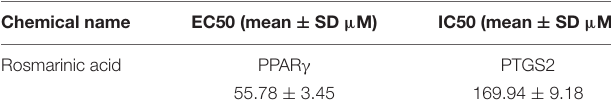
TABLE 3 | The relative affinity of RosA for PPAR γ and inhibitory activities against